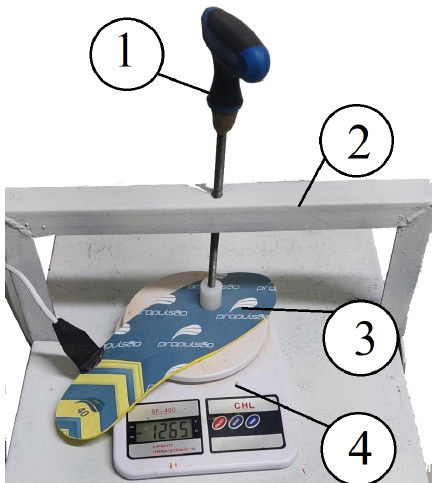
Figure A3. Device used for force dosing: 1—pressure lever; 2—fixing structure; 3—insole to be calibrated; 4—precision